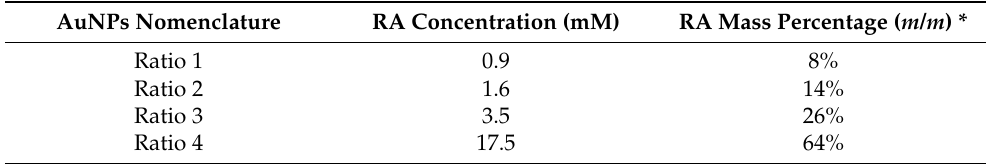
Table 1. Nomenclature used to identify AuNPs, RA concentration and overall mass